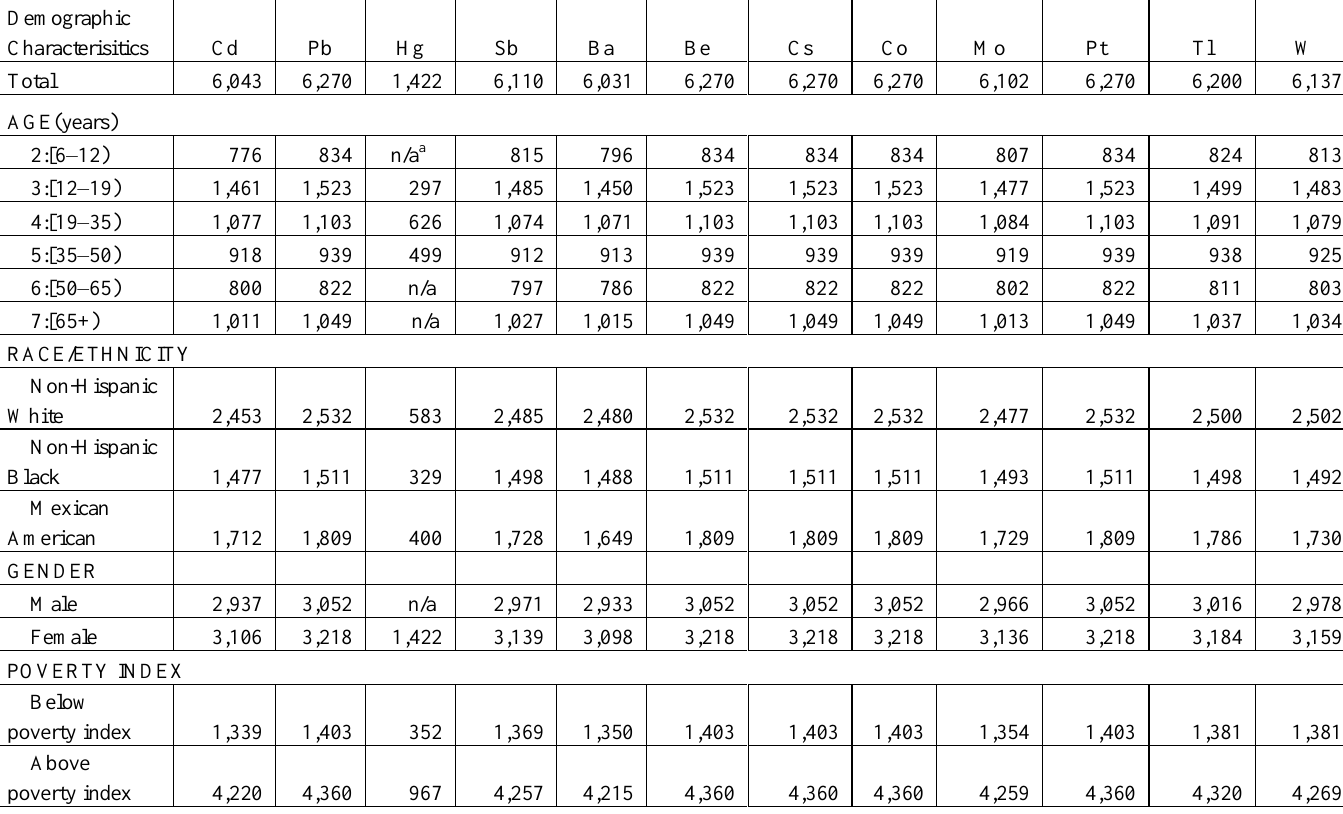
Table 1. Sample Size by Demographic Characteristics for 12 Urinary